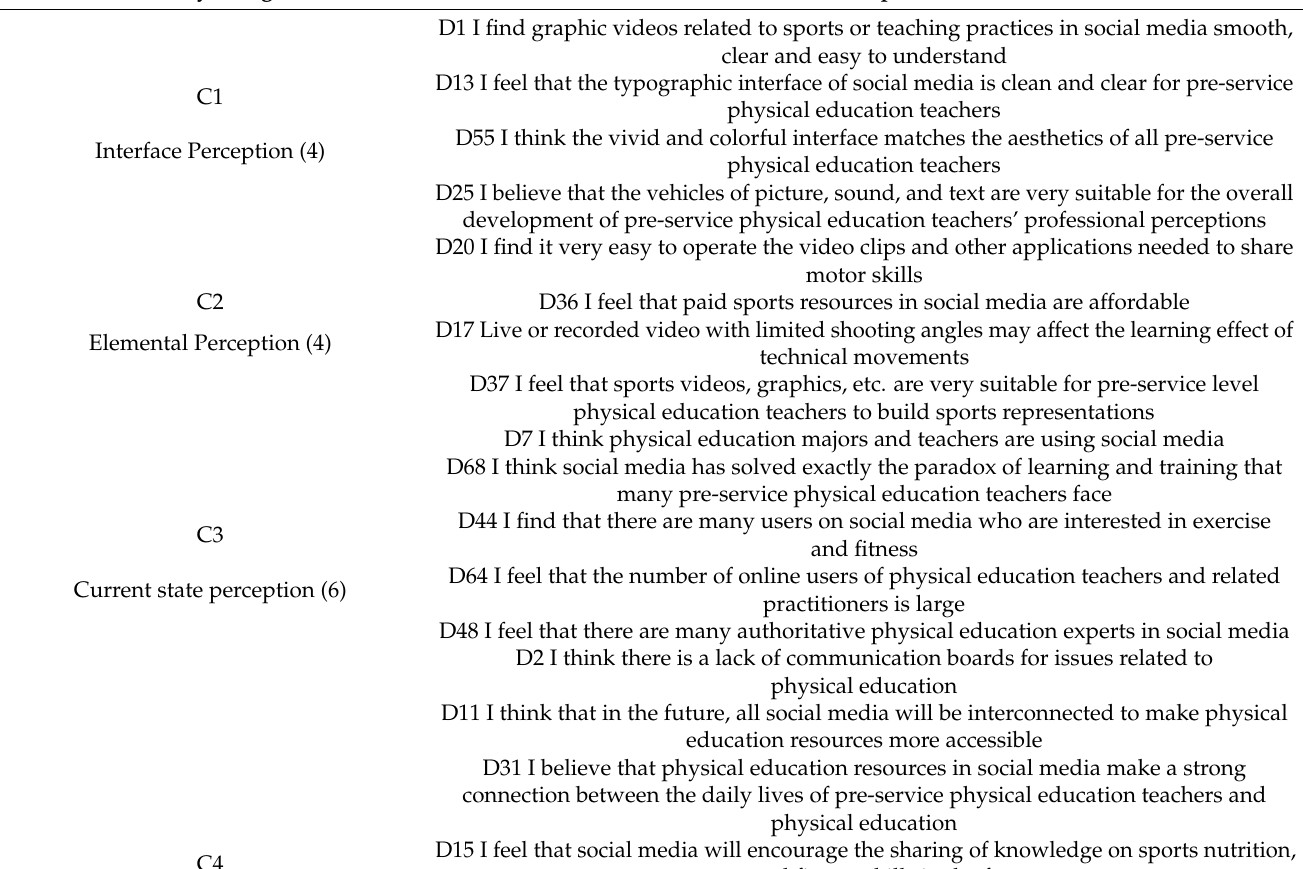
Table A3. Results of categorization of 70